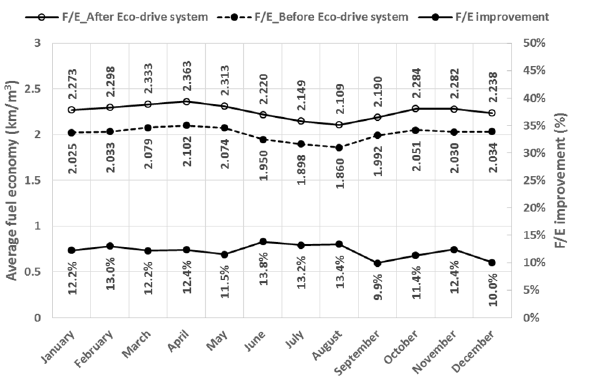
Figure 9. Fuel economy improvement of eco-drive system with eco-drive scoring.